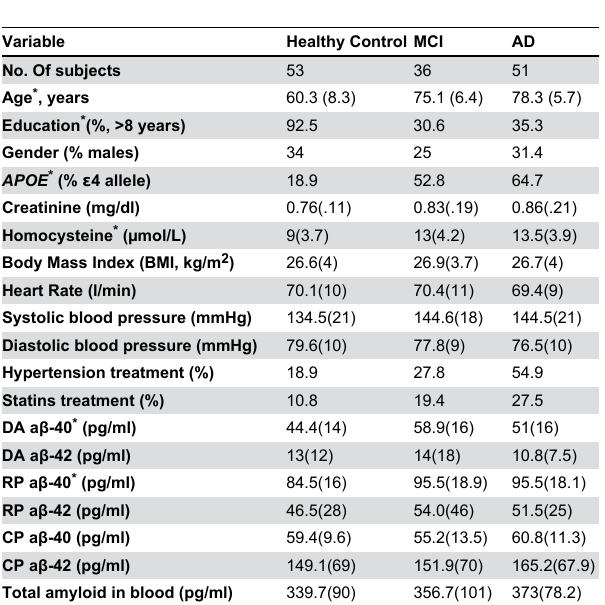
Table 1. Demographics and clinical characteristics of subjects